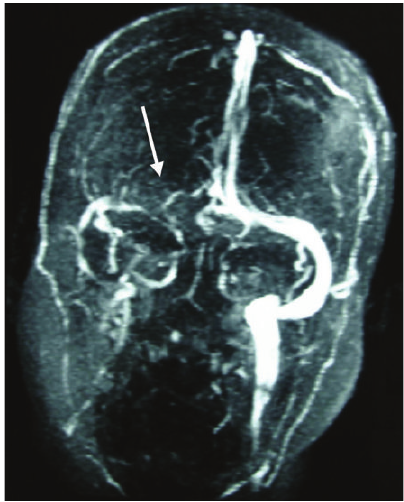
Figure 3: Magnetic resonance venography revealing narrowing of the right transverse sinus without the development of excessive collateral circulation.